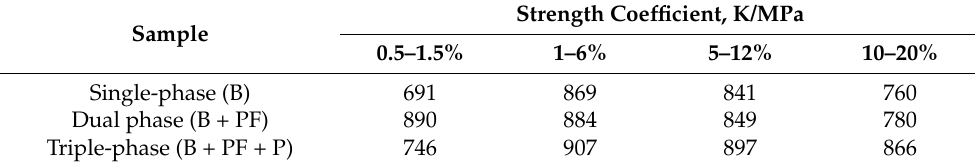
Table 4. The strength coefficient of three